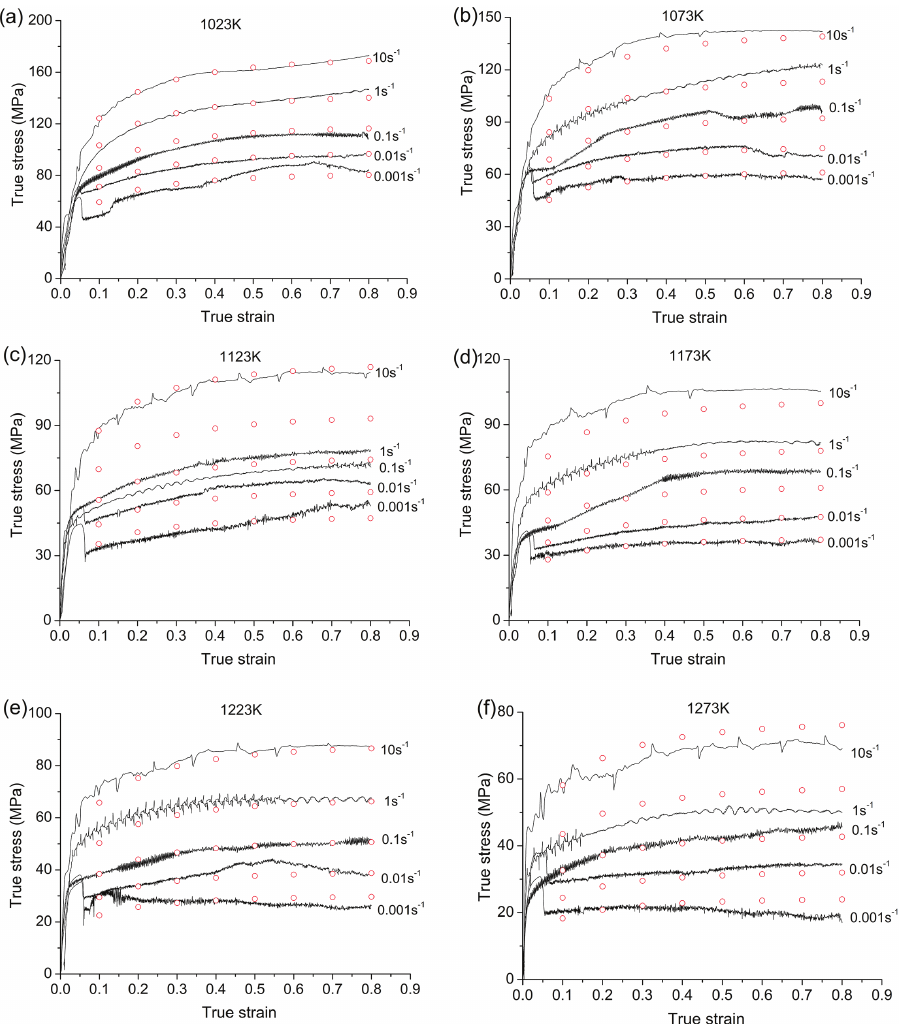
Figure 13: Comparison between the experimental and predicted flow stress at the temperature (a) 1,023K, (b) 1,073K, (c) 1,123K, (d) 1,173K, (e) 1,223K and (f)